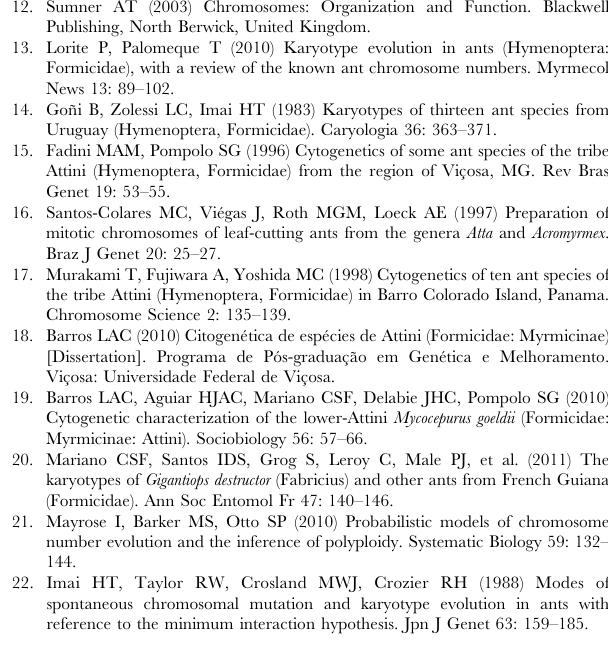
Table S1 Ant species used in this study for constructing the molecular phylogeny and their accession numbers in GenBank. Table S2 Models of evolution estimated for each gene and codon position with MrModeltest v3.7. The models listed below were employed for each data partition in a Bayesian analysis (see Material and Methods). Table S3 AIC scores and Maximum Likelihood (ML) estimates for the data set analyzed for each model implemented by ChromEvol